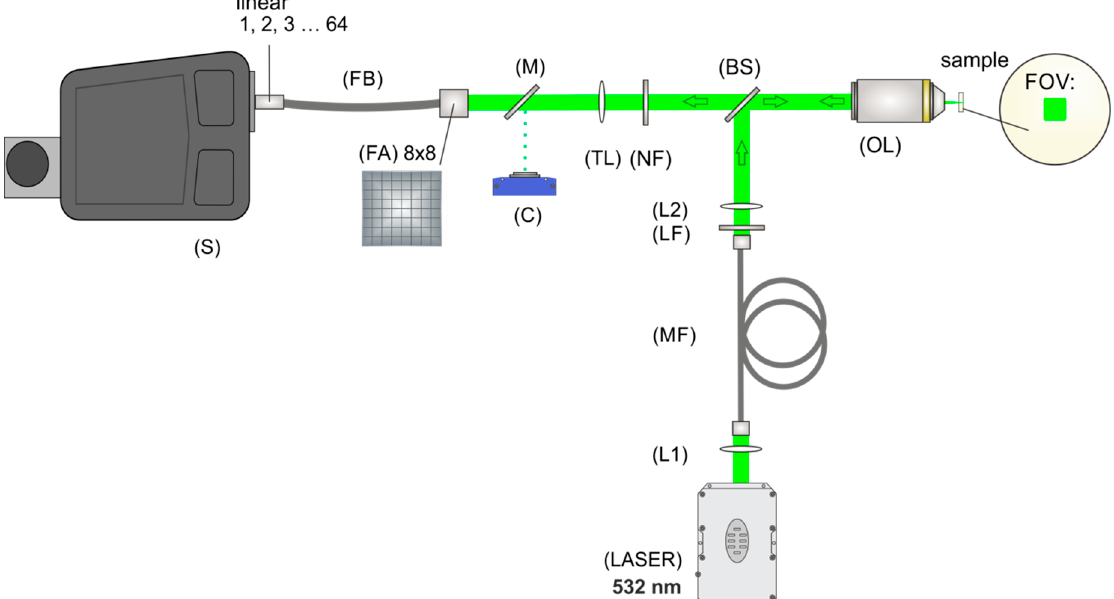
Figure 7. The experimental setup for fiber array-based Raman hyperspectral imaging is divided into an illumination and an imaging part, separated by a beam splitter (BS). The illumination part consists of a laser for excitation (LASER), two lenses (L1 and L2), a step index multimode fiber (MF), a cleanup filter (LF), and an objective lens (OL). Light is scattered back from the sample, collected by the same objective lens (OL), and imaged with the help of a tube lens (TL) onto the entrance face of a fiber array (FA). A suitable sample region can be chosen by directing the light onto a camera (C) with the help of a flip mirror (M). A notch filter (NF) removes the laser excitation wavelength and elastically scattered light. The scattered light is collected by the 8 × 8 array and is transformed with the help of a specially designed fiber bundle (FB) into a linear fiber array at the distal end and positioned in the slit plane of the spectrometer (S).